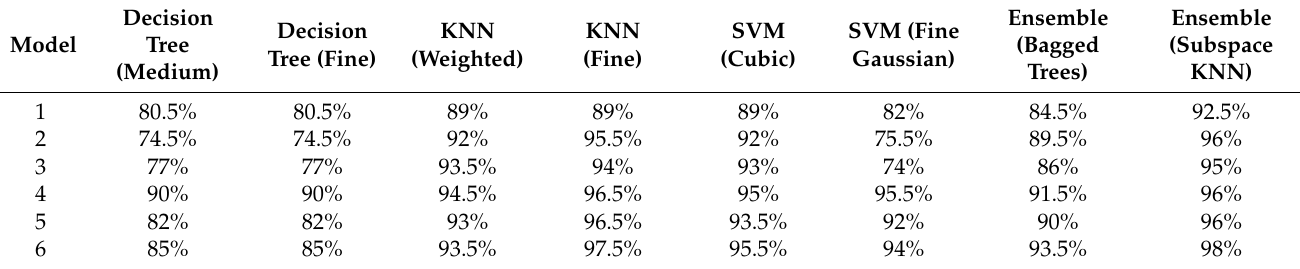
Table 1. Accuracy of machine learning training model prediction